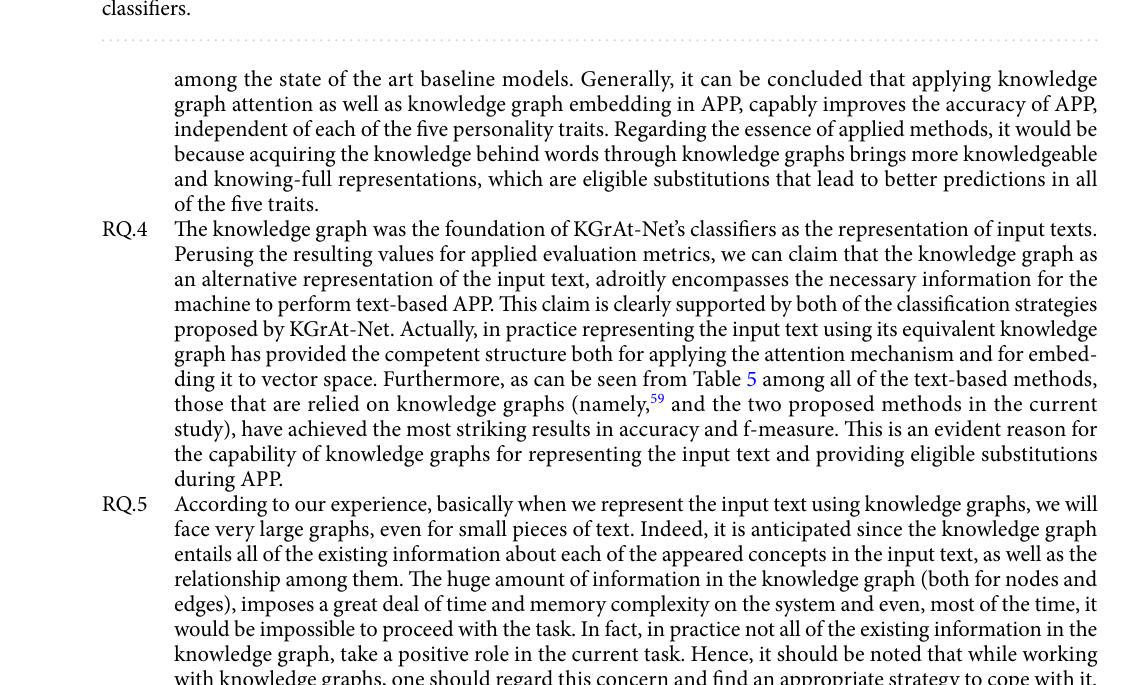
Figure 6. Comparing the accuracy of baseline models in each OCEAN traits, with KGrAt-Net’s two proposed